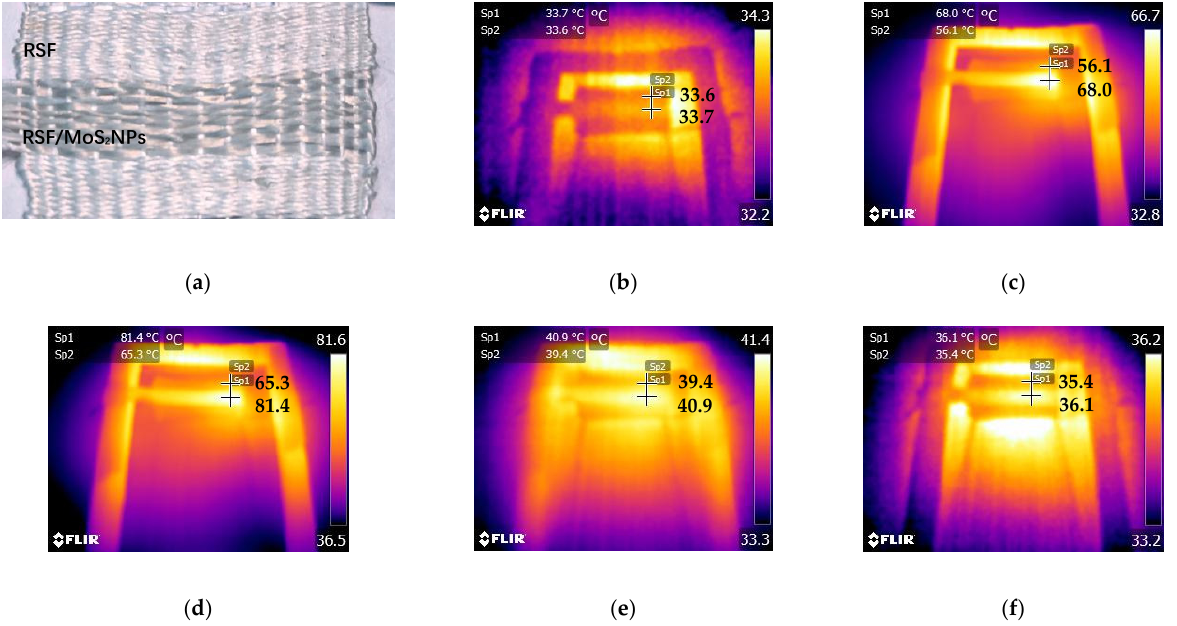
Figure 10. Temperature change of 2 wt% RSF/MoS 2 NPs woven fabric under the irradiation of simulated sunlight. ( a ) RSF/MoS 2 NPs fabric; ( b ) at the beginning of irradiation; ( c ) after irradiation for 1 min; ( d ) after irradiation for 10 min; ( e ) stop the irradiation for 1 min; ( f ) stop the irradiation for 10 min.